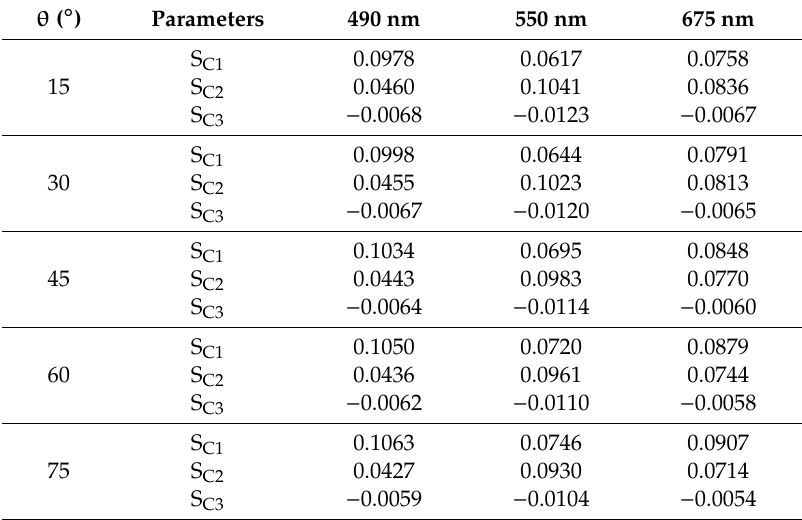
Table 3. Look up table of model parameters of Model C at different solar zenith angle ( θ = 15°, 30°, 45°, 60°, and 75°) at 490, 550, and 675 nm.